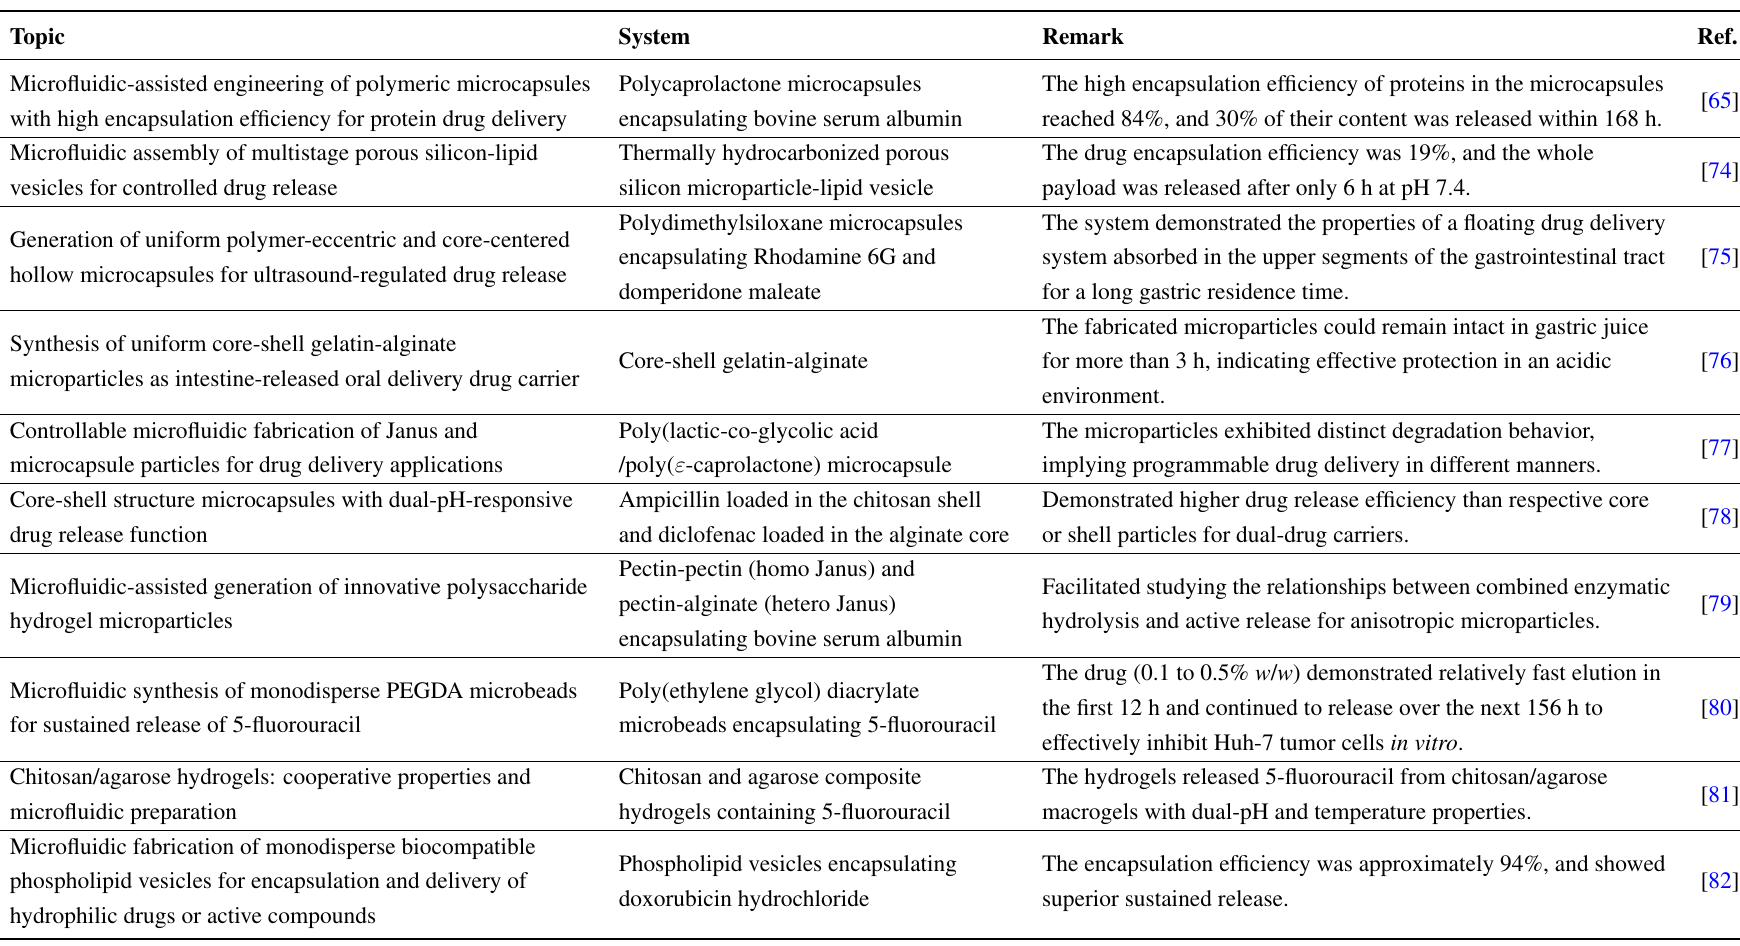
Table 3. Recent applications of droplet microfluidics in drug